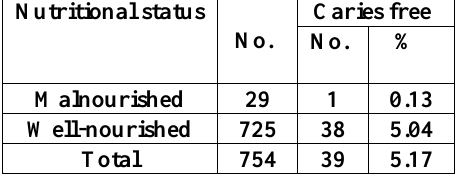
Table 4: Distribution of caries free among students by nutritional